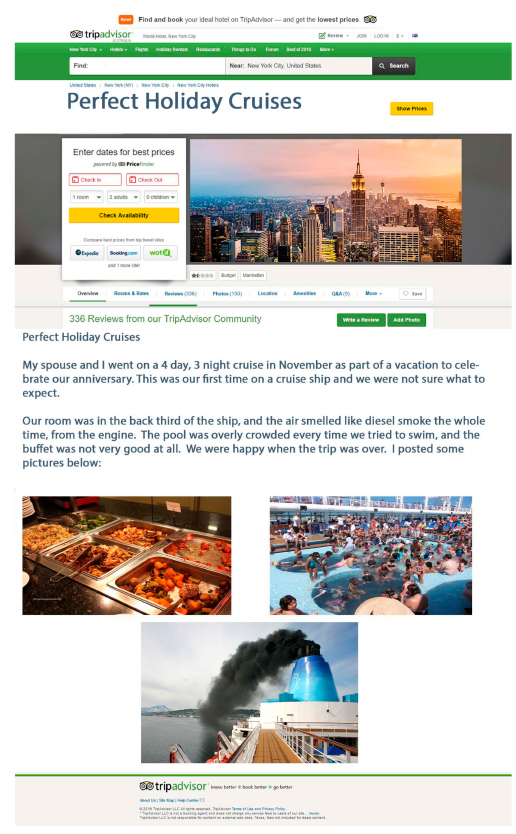
Figure A3. Cruise Ship, Negative Review, Negative